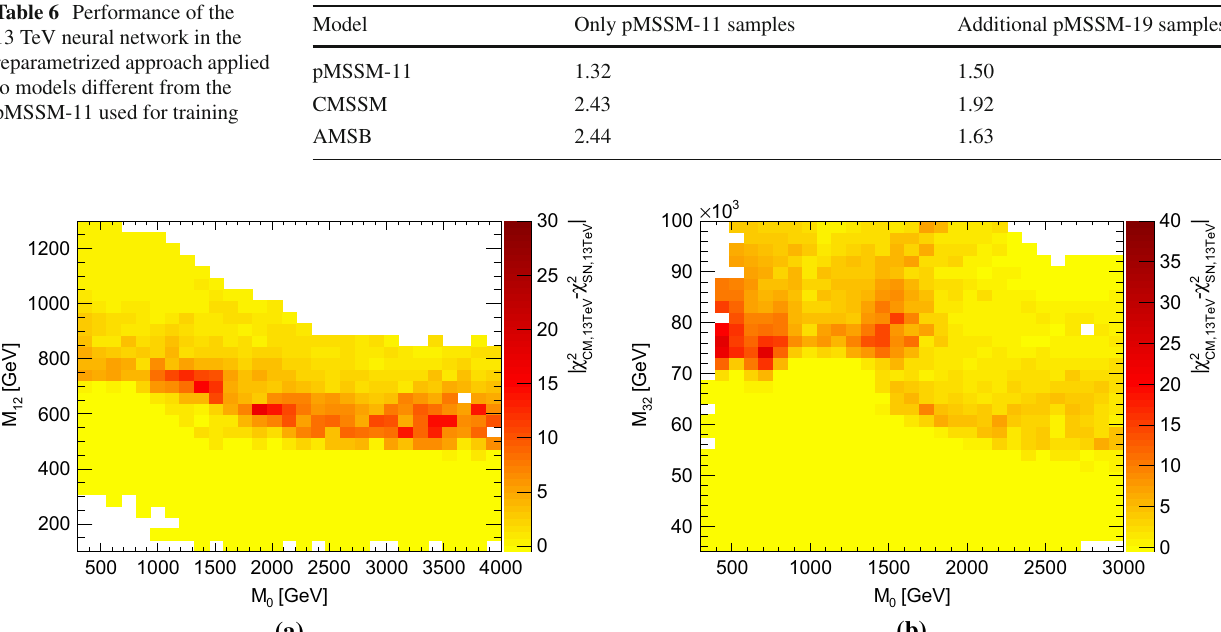
Fig. 17 Performance of the neural network trained on the reparametrized pMSSM-11 points with added samples containing non-degenerate stop sbottom pairs on the cMSSM ( a ) and AMSB ( b ). In each bin the mean difference was calculated for all validation points